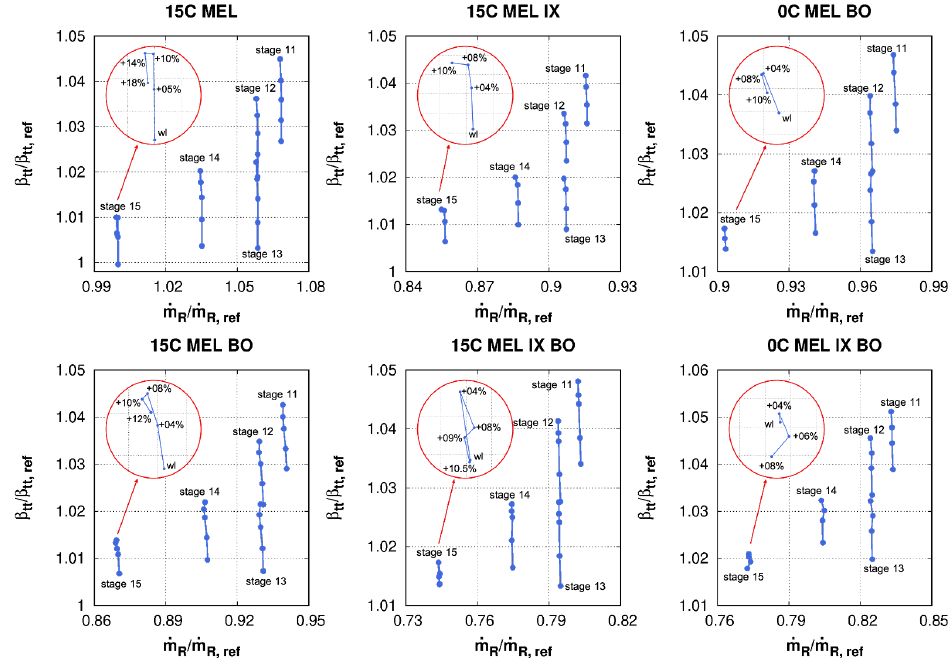
Figure 12. Map of the last five stages of the compressor for the six configurations analyzed.